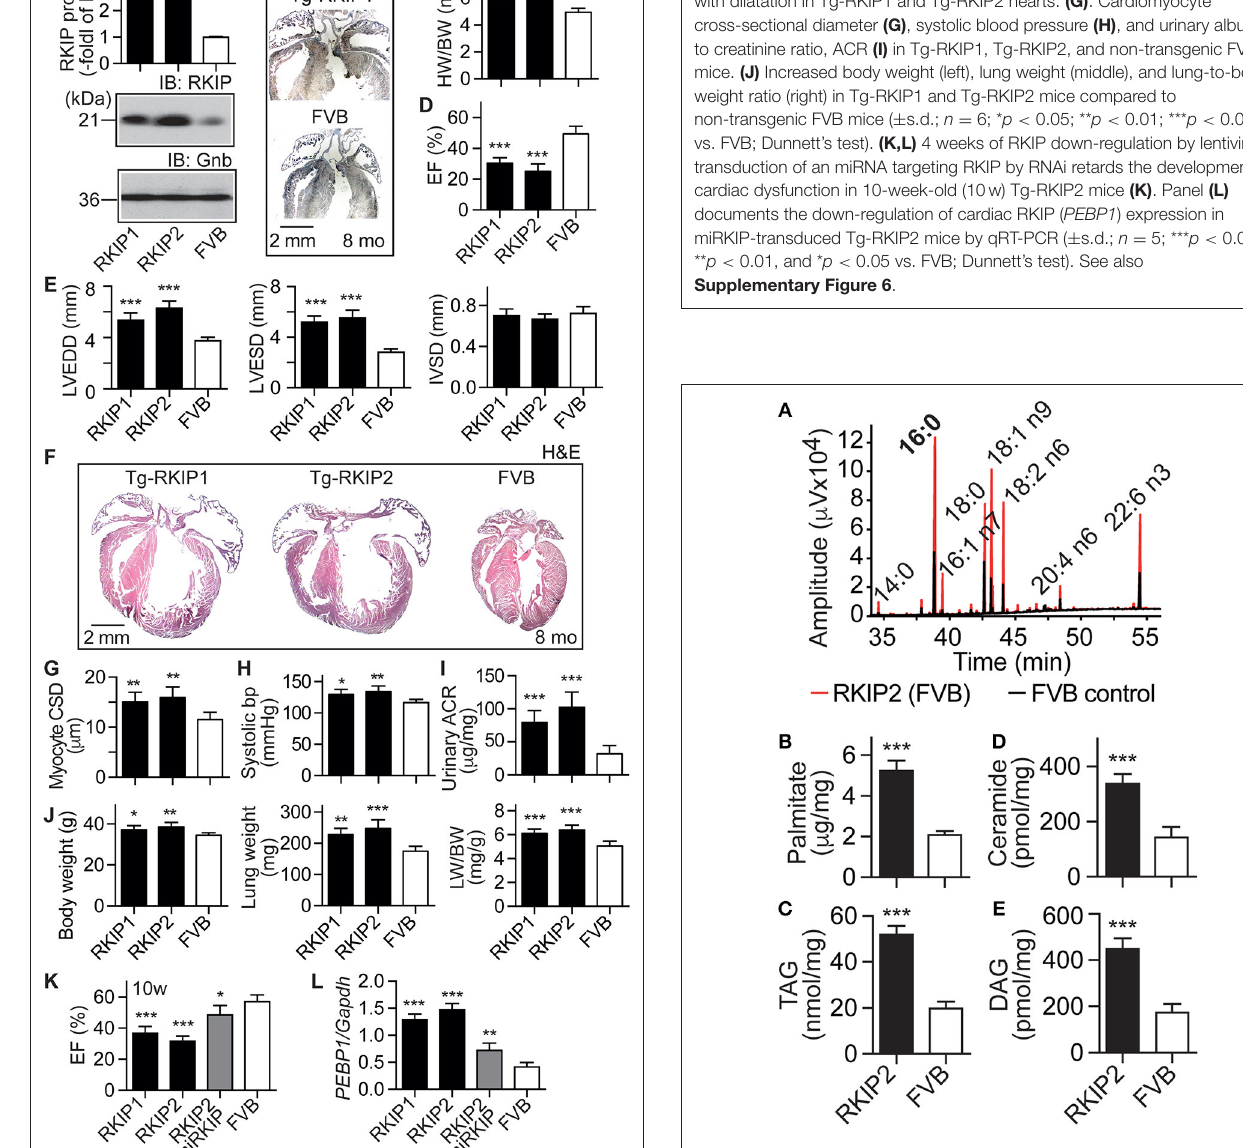
FIGURE 8 | RKIP promotes cardiac lipid overload in FVB background. (A–E) GC analysis of cardiac lipids (A) , cardiac palmitate (B) , TAG (C) , ceramide (D) , FIGURE 7 | RKIP induces symptoms of heart failure in FVB background. (A) and DAG (E) contents in 8-months-old Tg-RKIP2 mice with FVB background Cardiac RKIP protein levels were determined in Tg-RKIP1, Tg-RKIP2 and compared to age-matched non-transgenic FVB control mice ( ± s.d.; n = 6; non-transgenic FVB mice by immunoblot detection ( ± s.d.; n = 8; *** p < 0.001 *** p < 0.001). See also Supplementary Figure 7 . vs. FVB; Dunnett’s test). (B) Immunohistological localization of RKIP on cardiac sections from an 8-months-old Tg-RKIP1 mouse and an age-matched non-transgenic FVB mouse (bar: 2mm; nuclei were stained with hematoxylin, HE). Immunohistology is representative of four hearts/group. (C,D) smaller in Tg-GRK2K220R and Tg-GRKInh mice compared Heart-to-body weight ratio (C) , and cardiac left ventricular ejection fraction (D) to non-transgenic B6 mice whereas the interventricular septal of 8-months-old Tg-RKIP1, Tg-RKIP2 and non-transgenic FVB mice [ ± s.d.; n = 6 (C) , and n = 5 (D) ; *** p < 0.001 vs. FVB; Dunnett’s test]. (E) thickness was not significantly different between study groups Echocardiographic determination of left ventricular end-diastolic diameter (left), ( Figures 11D–F ). Together these findings present strong left ventricular end-systolic diameter (middle), and interventricular septal evidence that inhibition of GRK2 by dominant-negative GRK2- thickness (right) in 8-months-old Tg-RKIP1, Tg-RKIP2 and non-transgenic K220R exerts protection against cardiac dysfunction induced by (Continued) chronic pressure